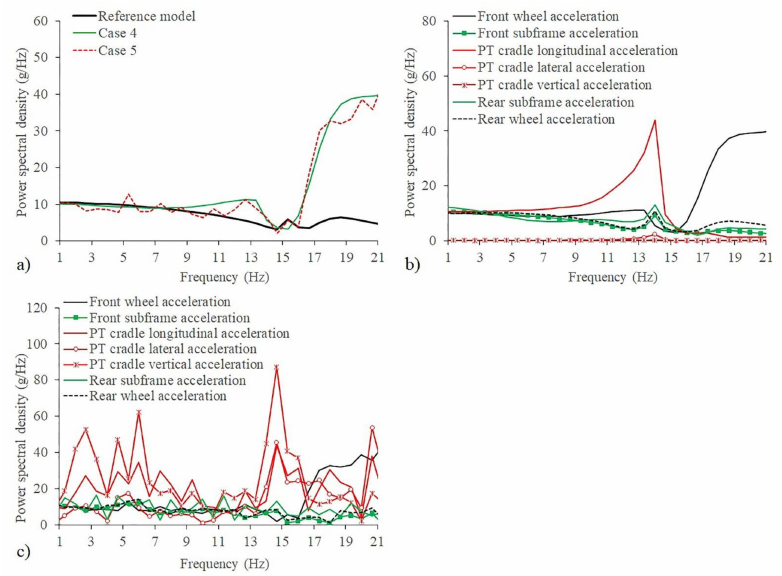
Figure 15. Tip-in event low-frequency resonances on the tarmac: ( a ) vehicle body; ( b ) case 4; ( c ) case